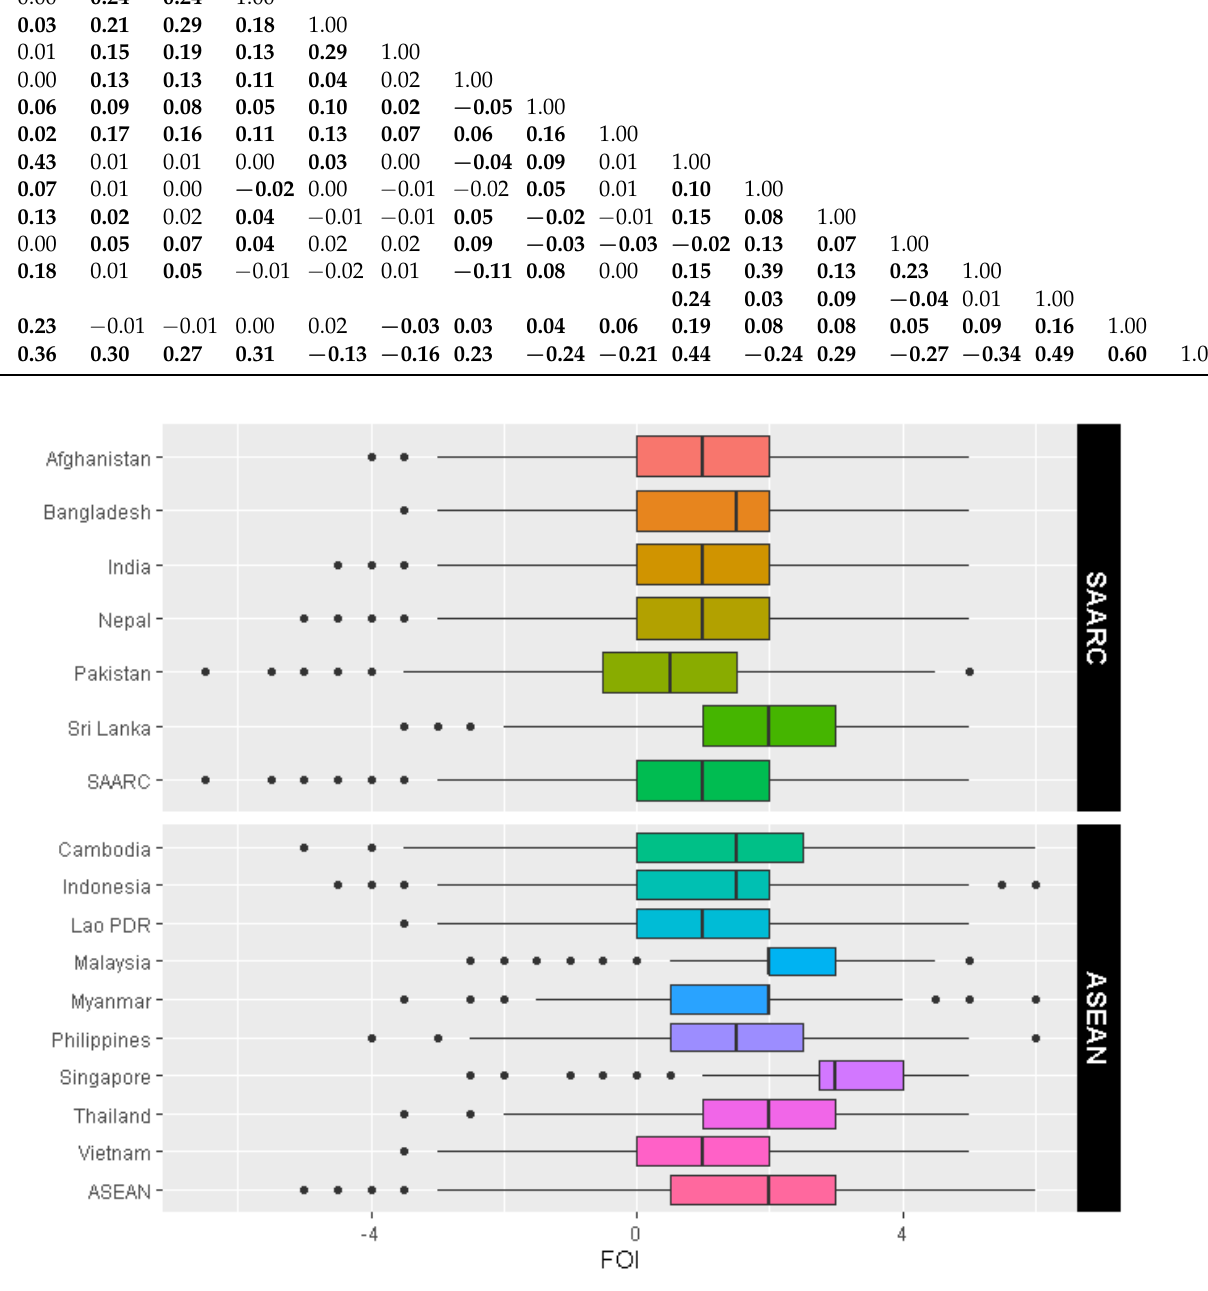
Figure 17. Distribution of the FinTech Opportunity Index (FOI).